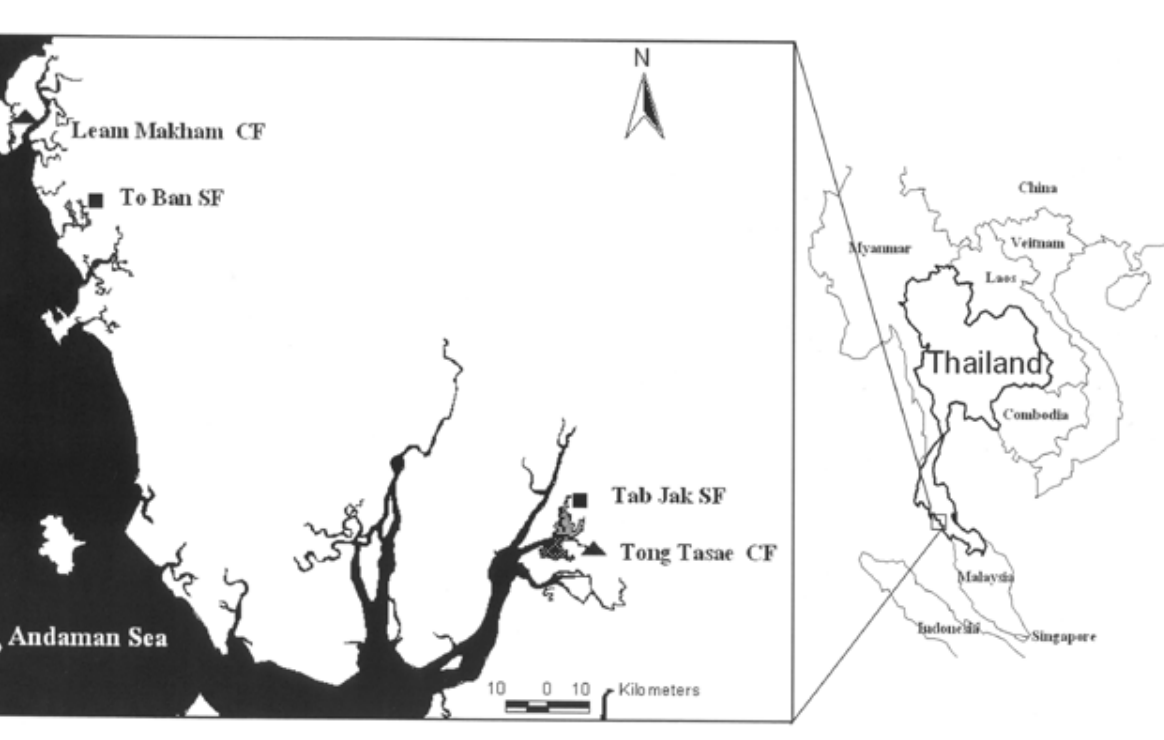
Fig. 1. Map of the studied mangrove community forests (CF) and state forests (SF) in seaward and landward sites in Trang, southern